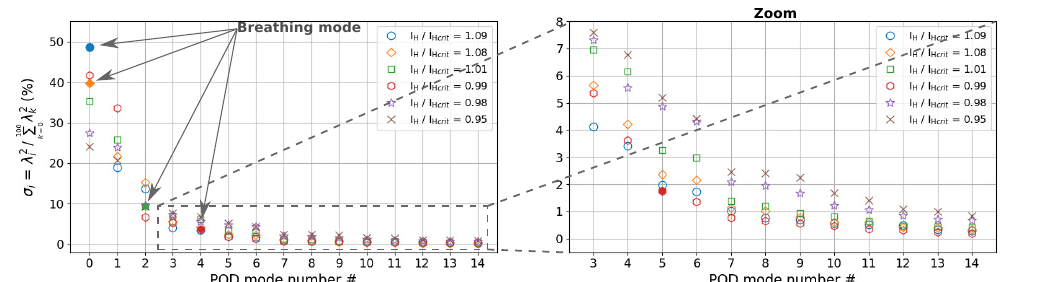
Figure 9. Evolution of the relative singular values λ i given as σ i = λ 2 expressed as a percentage for the 14th first POD modes and for different values of the heating current ratio I H / I H , crit . For each value of I H / I H , crit , the mode corresponding to the breathing mode is represented with a filled